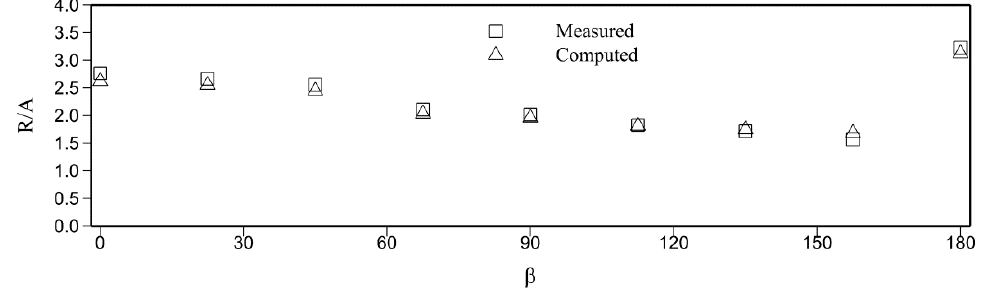
Figure 4. Run ‐ up around the conical island. Figure 4. Run-up around the conical